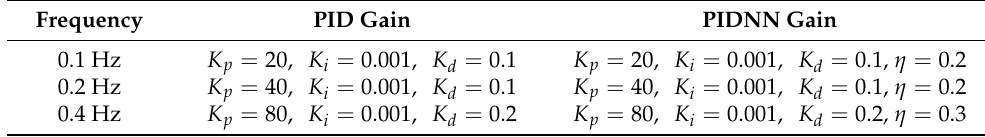
Figure 10. The experimental setup: ( a ) bi-directional tendon-driven actuator, microcontroller unit, controller area network, brushless direct current motor and motor driver for motor control; ( b ) The overall experimental setup attached to a rigid body. Table 2. Controller parameter at the frequency of each sinusoidal ( η = learning rate).